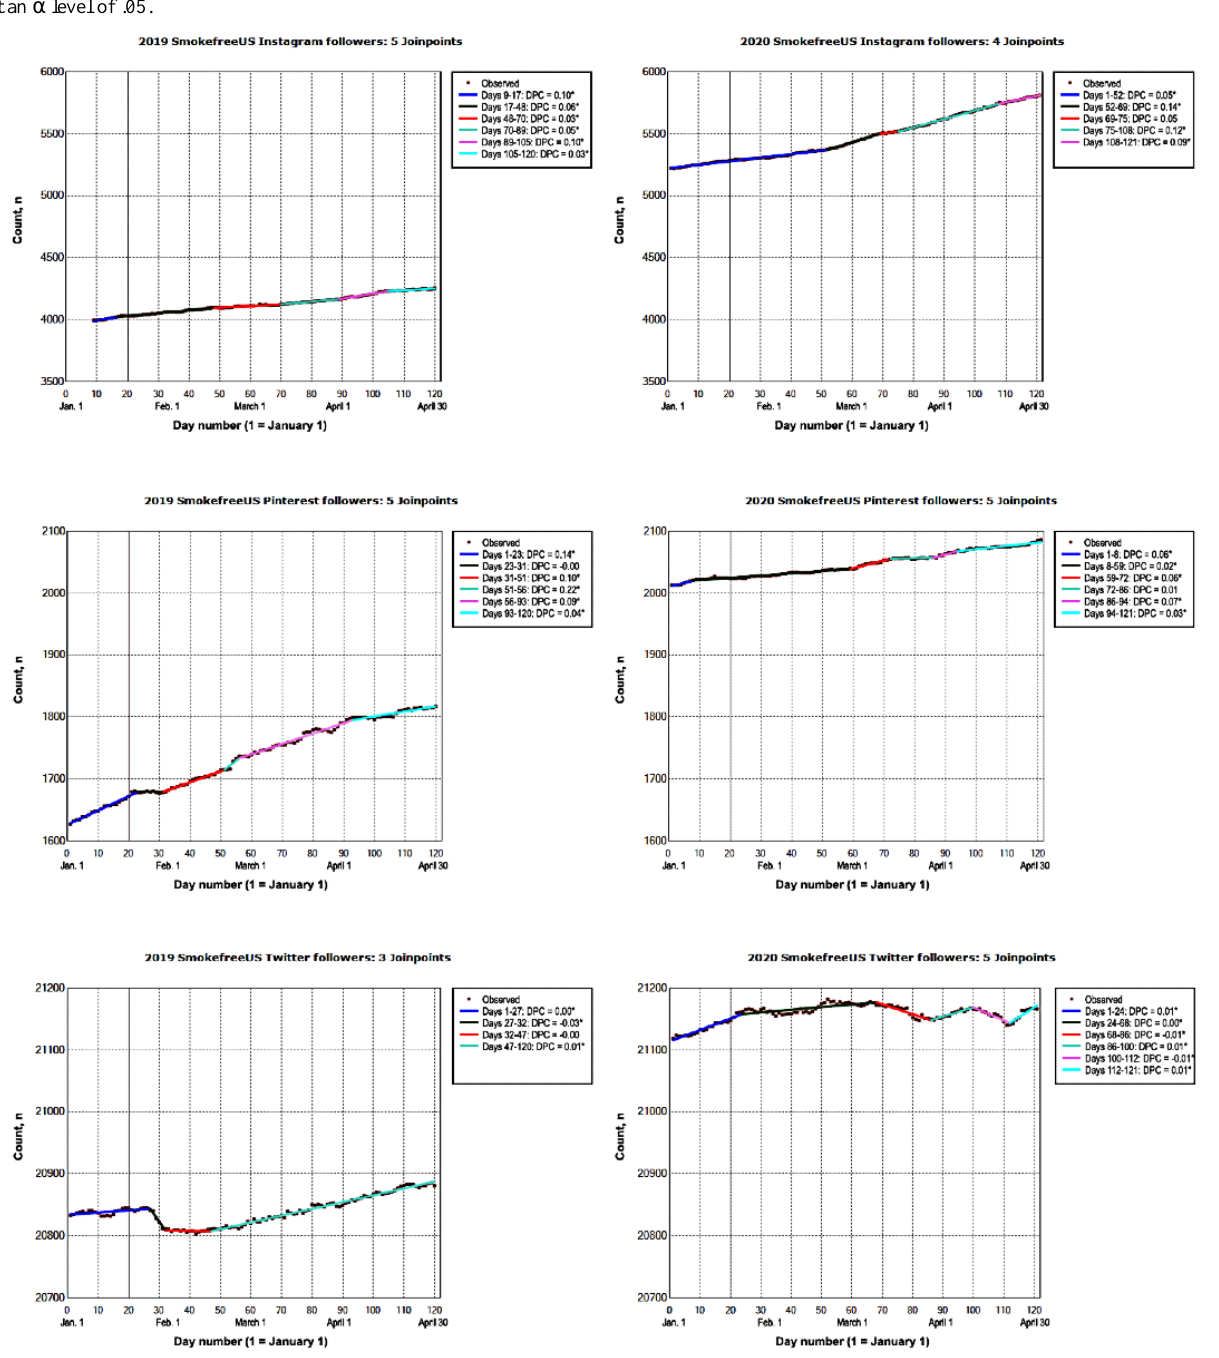
Figure 3. The number of SmokeFreeUS Instagram, Pinterest, and Twitter followers from January to April 2019 and 2020. The vertical line represents January 20. On this day in 2020, the first laboratory-confirmed COVID-19 case was identified in the United States. This was reported to the Centers for Disease Control and Prevention on January 22, 2020 [43]. Data on the number of daily SmokeFree Instagram followers were missing for the first 8 days in January 2019. Data on model selection appear in Multimedia Appendix 1. DPC: daily percent change. *The DPC is significantly different from 0 at an α level of